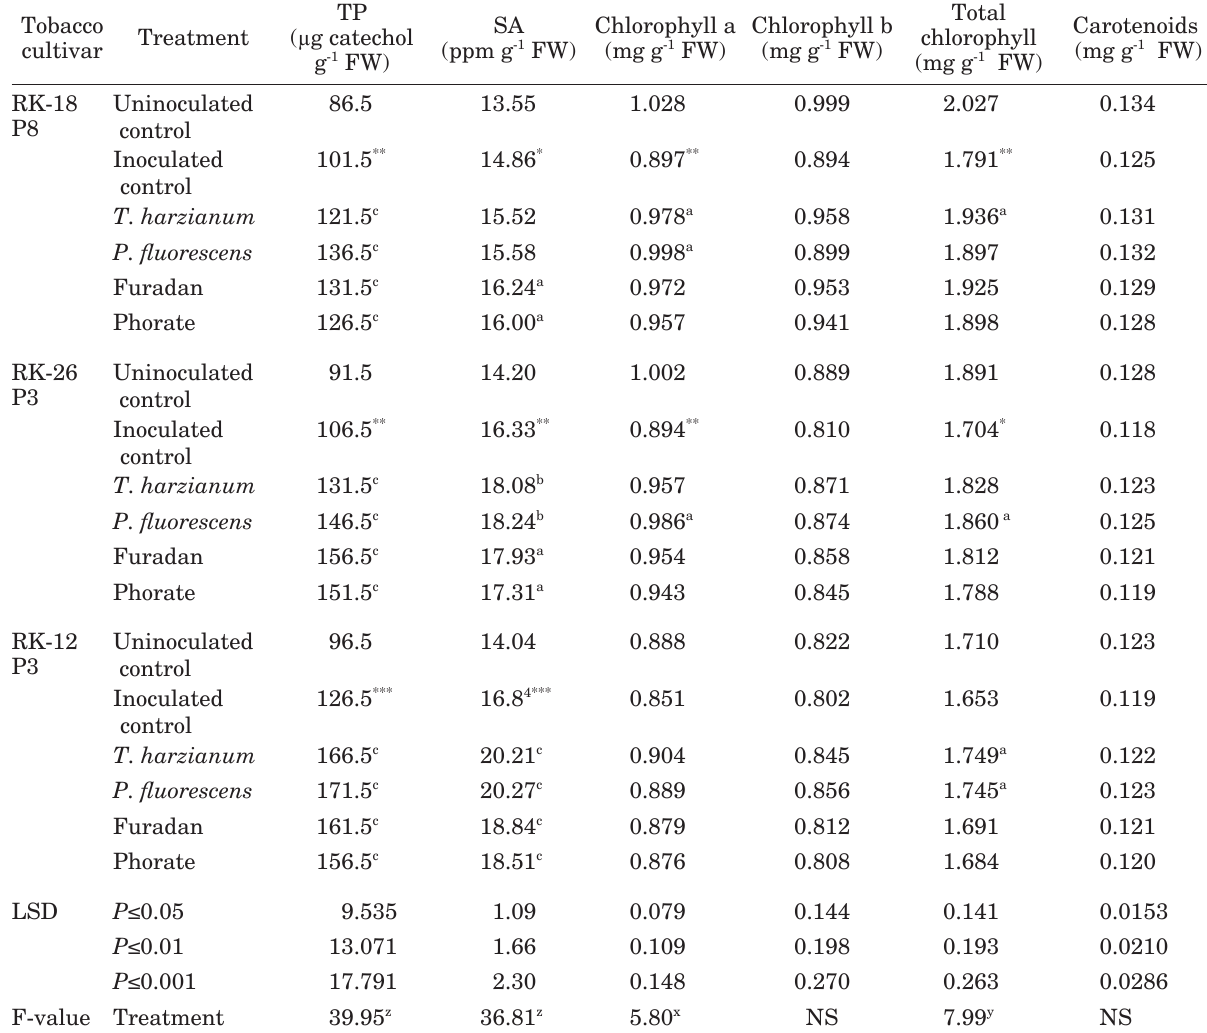
Table 2. Effects of biocontrol agents and nematicides on leaf total phenol (TP), salicylic acid (SA), chlorophyll and carotenoids contents of tobacco cultivars inoculated with Meloidogyne incognita (2000 J mean of three